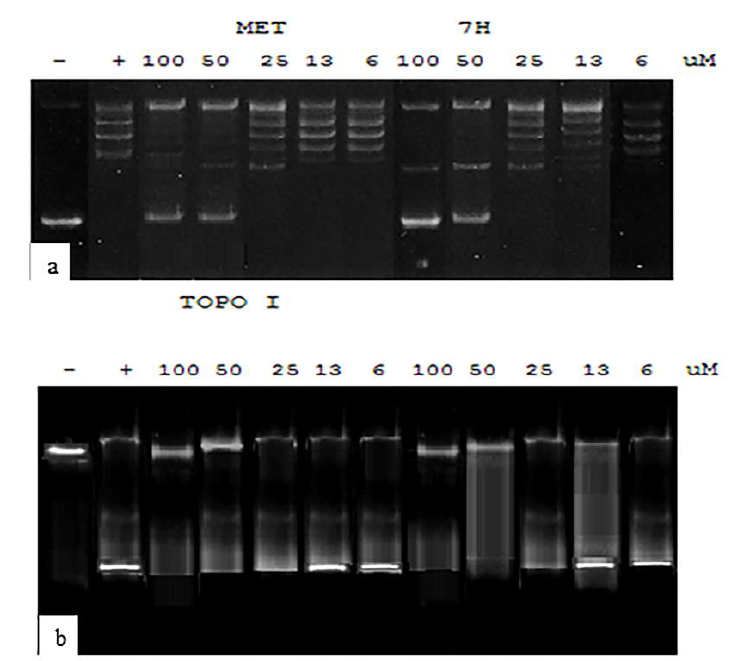
Figure 15. Topoisomearse I and II assay results after incubation with conc 5–100 µ M 7H . ( a ) Super- coiled DNA marker is indicated in lane 1 ( − ). Lane 2 (+) shows relaxed DNA marker. Complete activity is seen when no supercoiled DNA substrate remains (last lane) and partial activity with some supercoiled DNA (lane 6) using methotrexate. ( b ) 7H compound dose dependent effect on topoisomerase, showing complete inhibition starting from 50 uM concentration (lane 2) and partial activity at lane 4 (12.5 uM). Lane 1: kDNA catenated DNA marker, lane 2, kDNA digested Xho1, Lane 3 to last lane show kDNA + topo II with different concentrations of methotrexate.